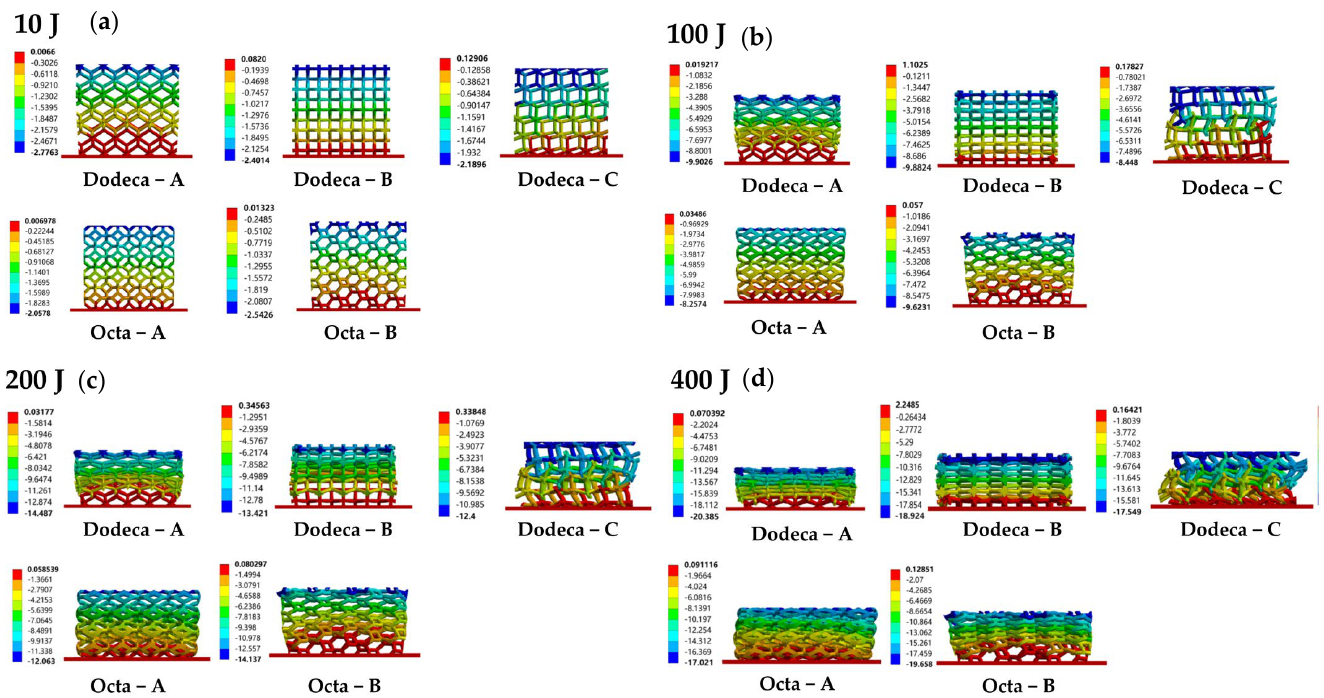
Figure 9. Comparison of deformation modes of 90%-porosity structures at different impact energies: